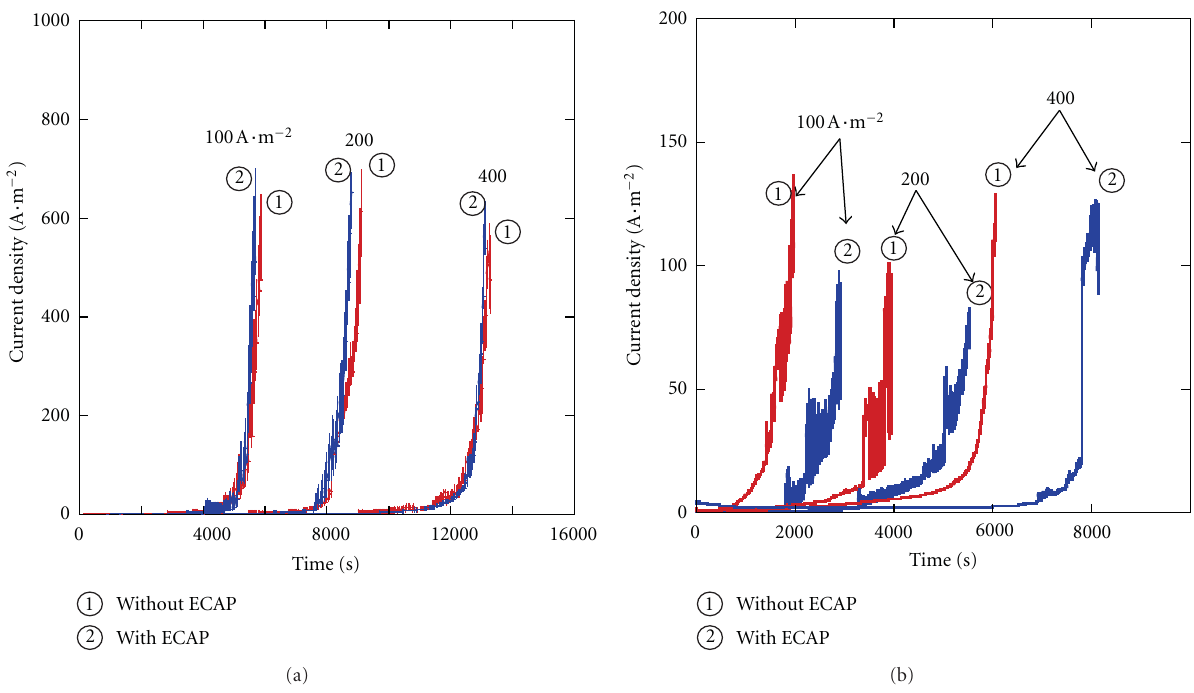
Figure 8: Time-dependence of the anodic current density of pure Al (a) and Al (AA1100) (b) anodized at 100, 200, and 400 A · m − 2 while kept at a constant potential of 1.2V in 0.2 mol · dm − 3 of AlCl 3